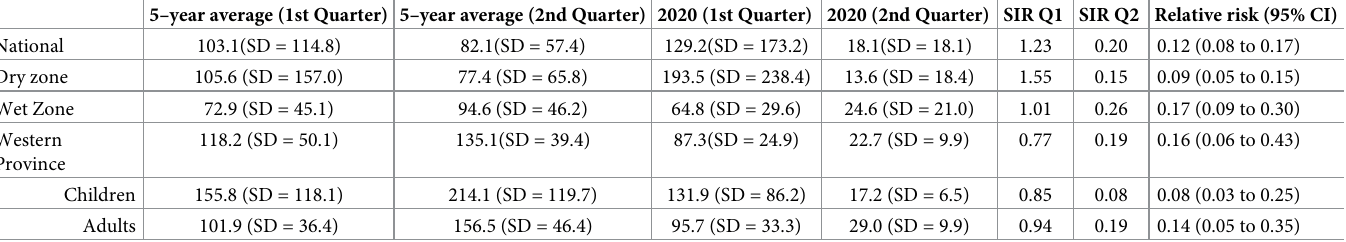
Table 1. Quarterly distribution of dengue incidence and the relative risk estimates by national, zonal levels and by age groups in the western province in Sri Lanka. Quarterly distribution of dengue cases per 100,000 population in the first (January to March) and the second (April to June) quarter in 2020 compared to that of five-year average (2015 to 2019). The average values are presented with their respective standard deviation (SD). Standardized incidence ratio (SIR) and meta estimated relative risk with 95% confidence interval are presented.